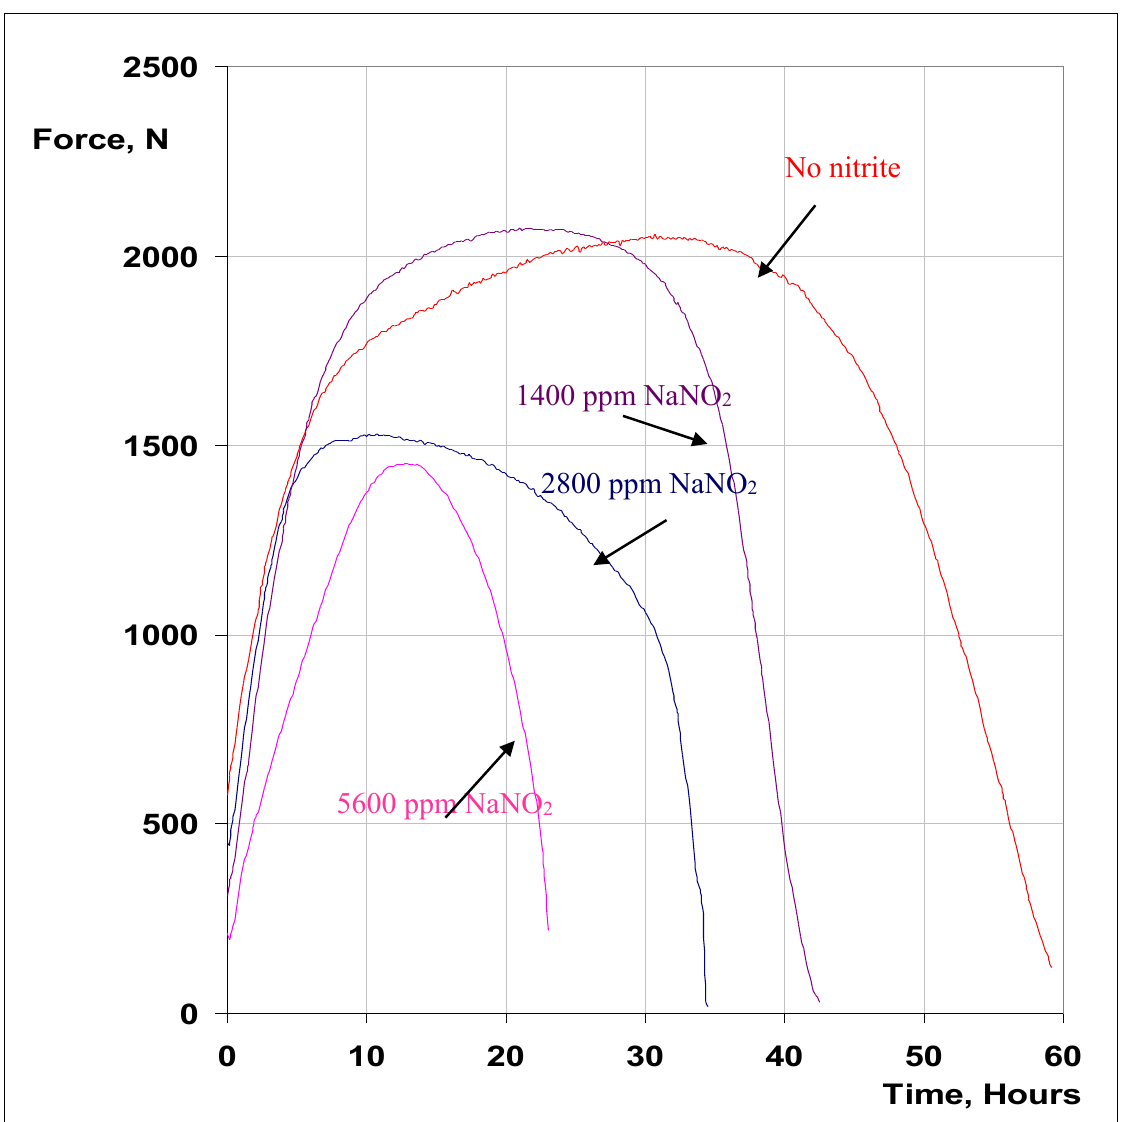
Figure 5. Force vs. Time SSRT curves (at strain rate of 3.7 × 10 −7 s −1 ) for 316L in 30 wt. % MgCl 2 at 150 °C, with different concentrations of NO 2−